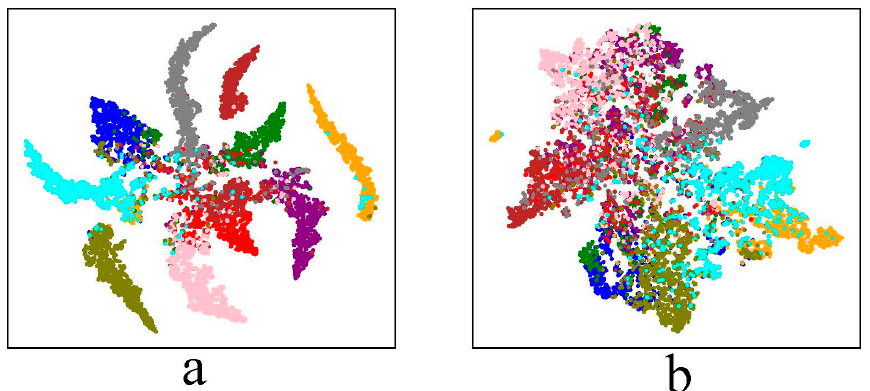
Figure 6. t-SNE visualization of the feature distribution of clean examples and adversarial examples of an 11-layer CNN trained for 100 epochs. Examples of the same color have the same ground-truth label. ( a ) Clean examples of the standard trained model. ( b ) Adversarial examples of the adversari- ally trained